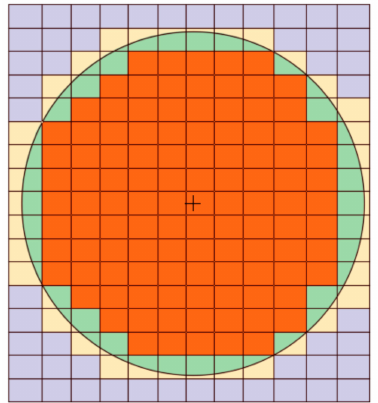
Figure 5. Discrete determination of the average velocity over the cells that are completely inside the boundary.